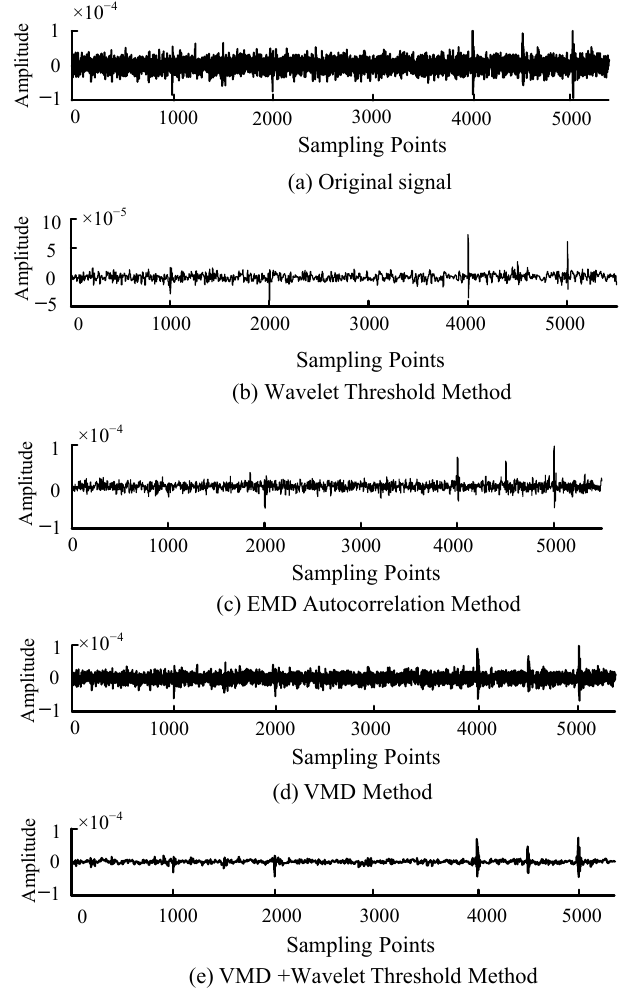
Figure 7. Comparison of four methods of denoising effect (original SNR is − 2.673 dB).